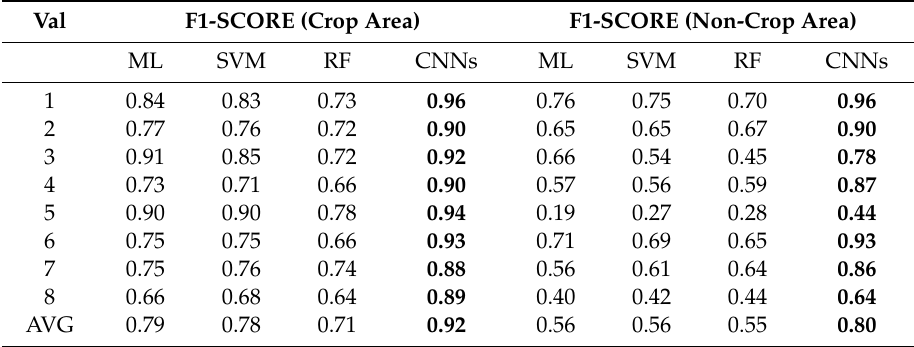
Table 6. Comparisons of Maximum Likelihood (ML), Support Vector Machine (SVM), Random Forest (RF), and Convolutional Neural Networks (CNNs) on pixel-wise classification. Val F1-SCORE (Crop Area) F1-SCORE (Non-Crop Area)